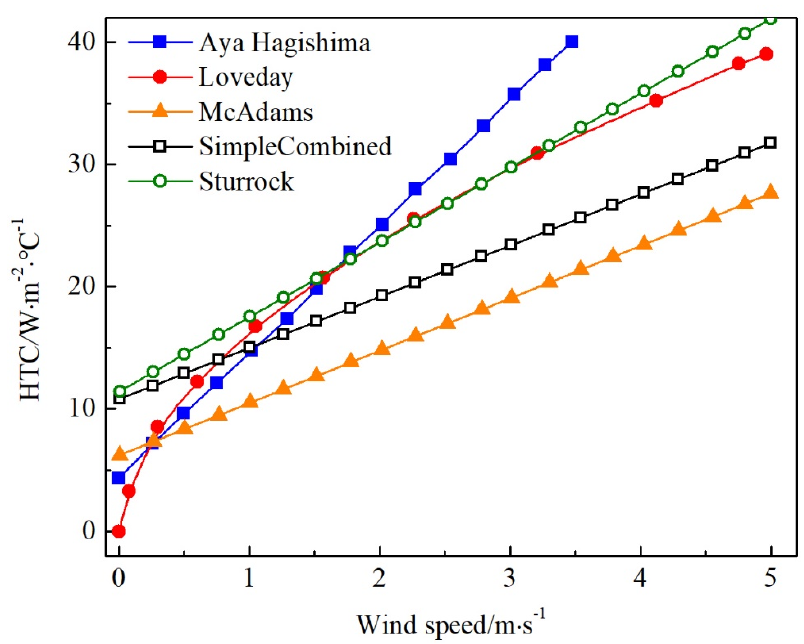
Figure 1. Comparisons between different surface heat transfer coefficients (SHTCs) (convective heat transfer coefficients, CHTCs).